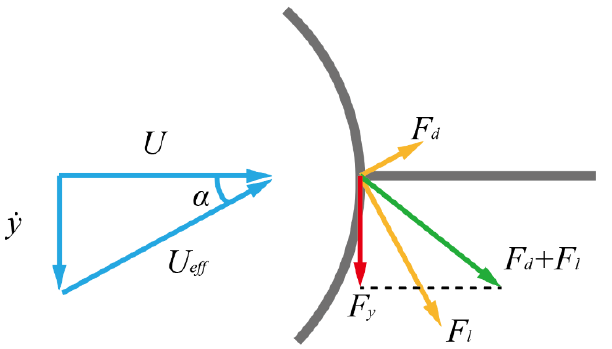
Figure 10. Definitions of wind attack angle and forces in the force measurement tests.